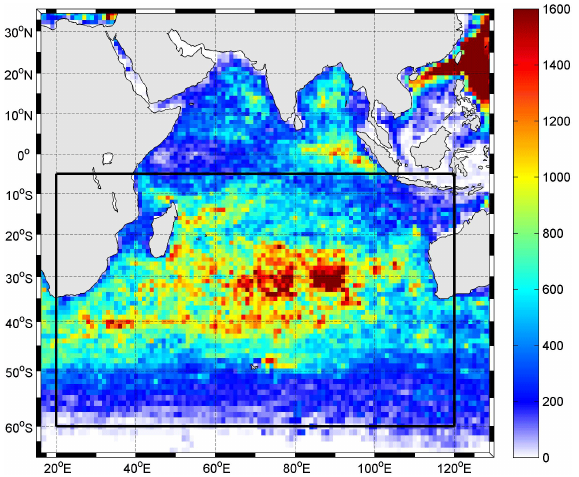
Figure 3. Number of drifters passing through each 1 ◦ × 1 ◦ bin in their trajectories.